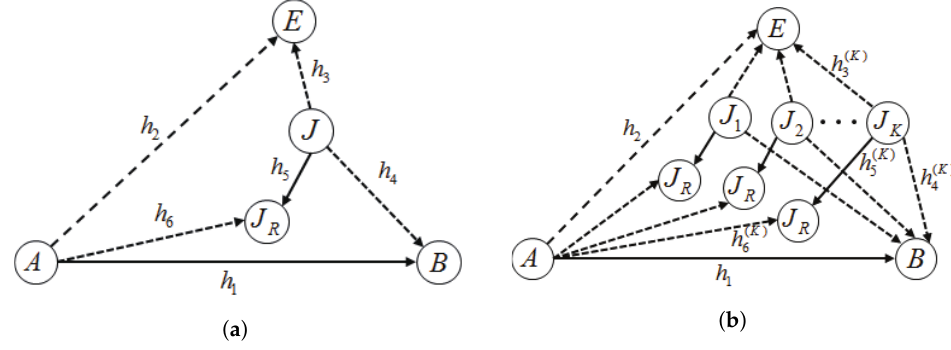
Figure 1. The system models: ( a ) single-jammer model; ( b ) multiple-jammer